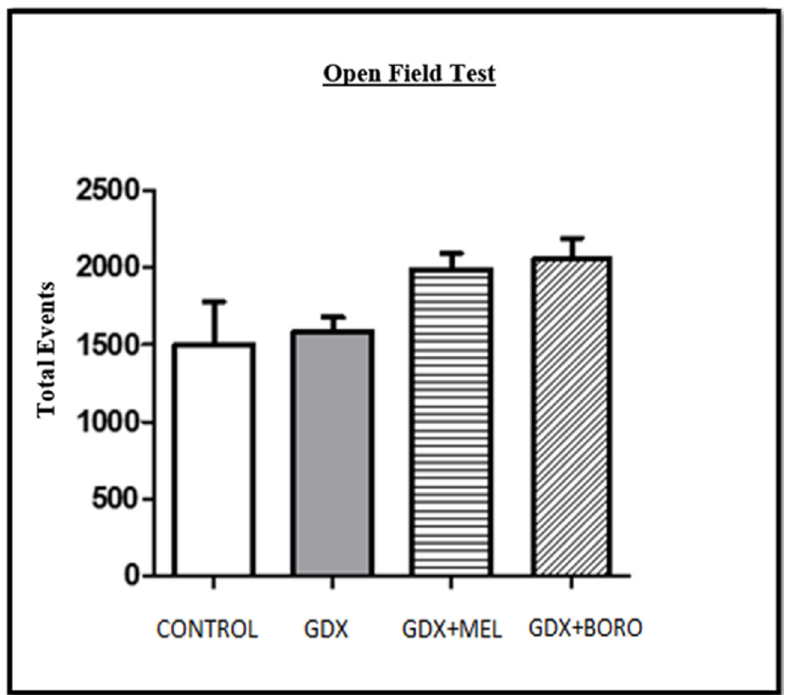
Figure 9. Motor performance in the open-field test at the post-treatment evaluation. No difference was found among groups. Results are expressed as mean ± SEM ( n = 8). GDX, gonadectomized; MEL, melatonin; BORO, Borolatonin.